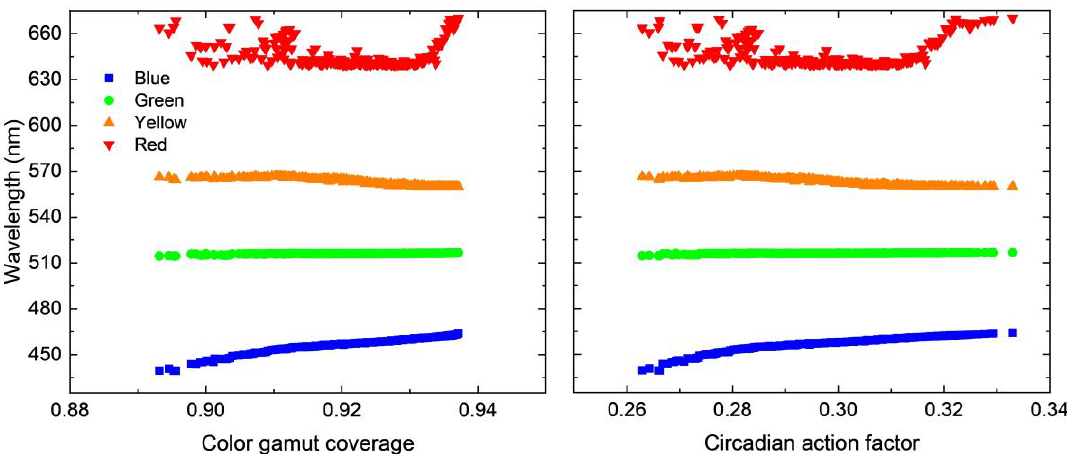
Figure 7. Correlation between objectives (CGC and CAF) and the central wavelengths of the RGB micro-LED display and the yellow phosphors, where the bandwidth of the yellow phosphor was 60 nm (RYGB-type). Table 1. Central wavelengths and performance of two micro-LED